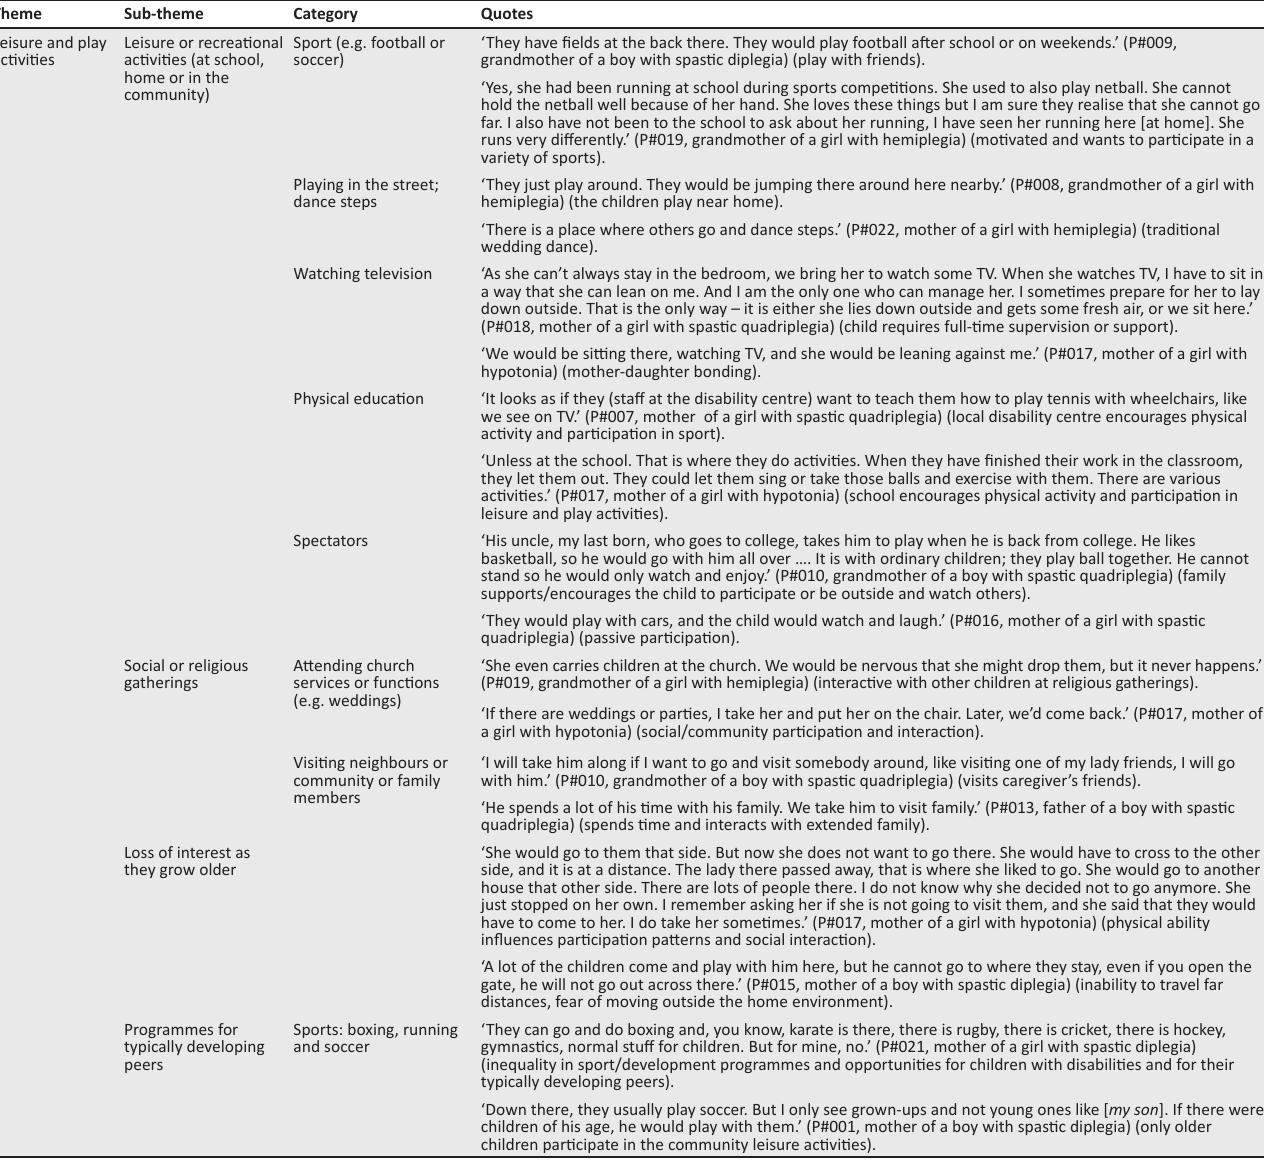
TABLE 5: Participation in leisure and play activities based on interviews with